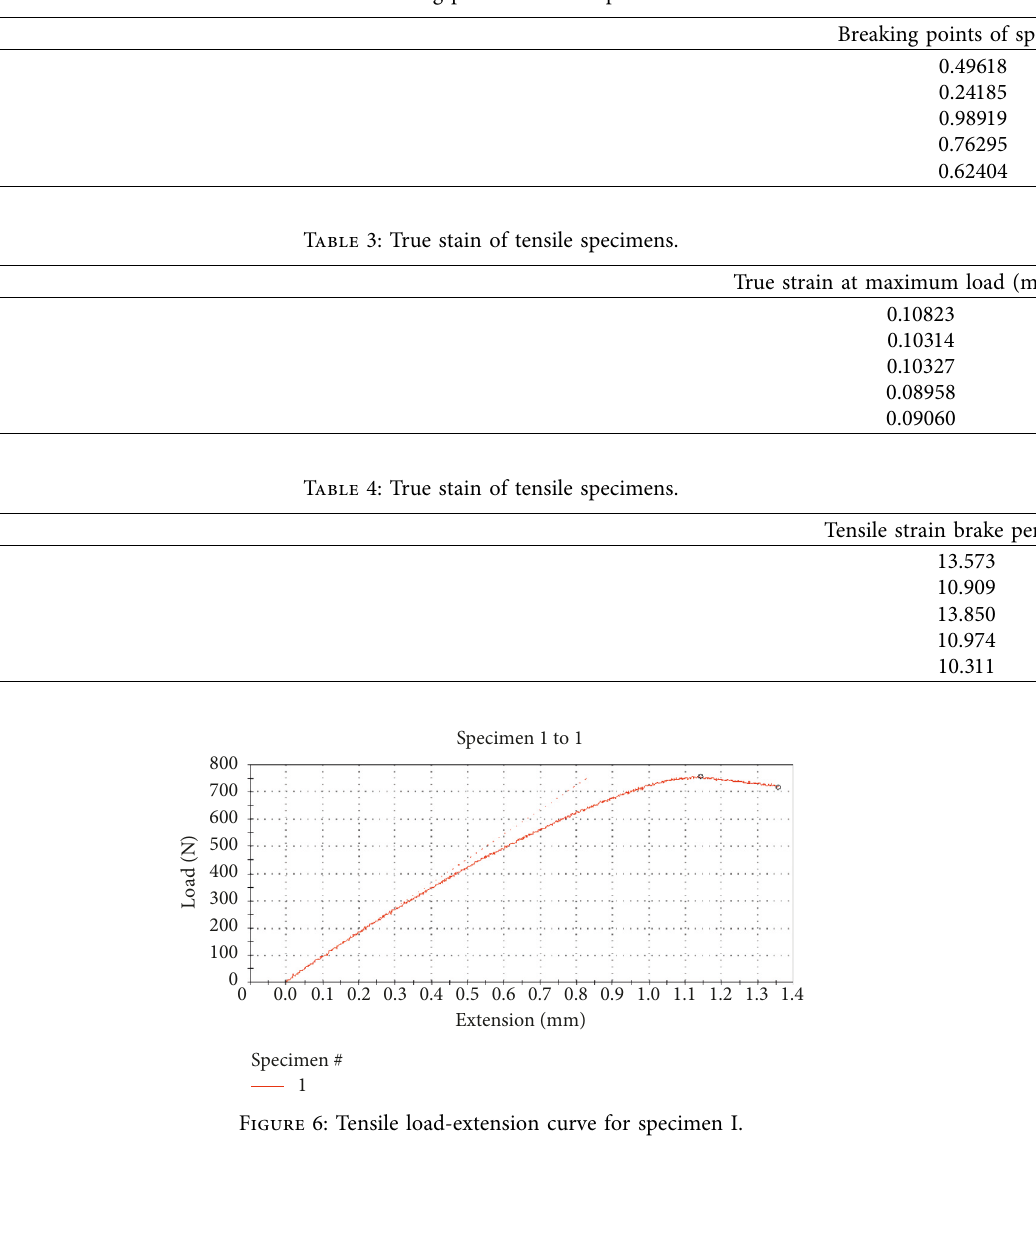
Figure 5: Failure tensile specimens (after tensile test). Table 2: Braking point of tensile specimens.